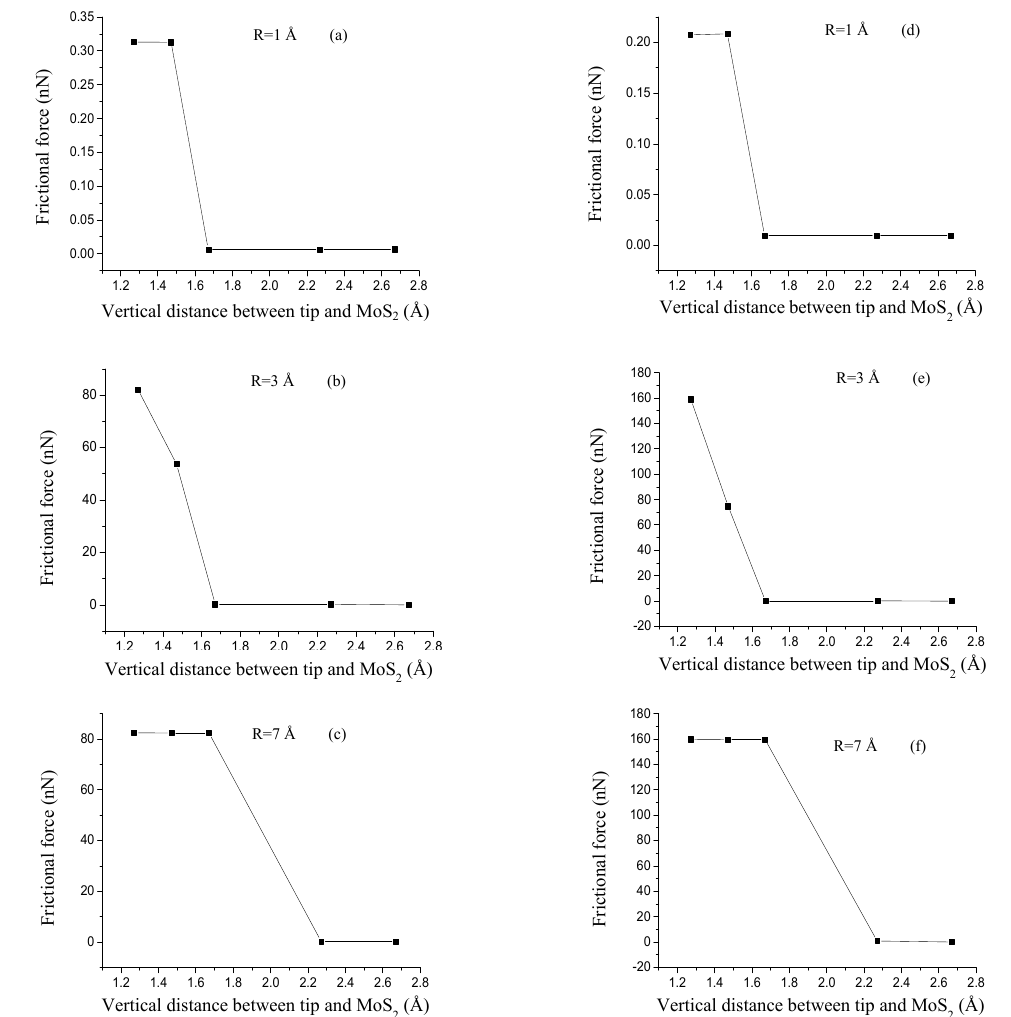
Figure 8. Variations in frictional forces for three different tips (radii of 1, 3, and 7 Å) sliding along the AC ( a – c ) and ZZ ( d – f ) orientation with five vertical distances between tips and MoS 2 , z = 1.27 Å, z = 1.47 Å, z = 1.67 Å, z = 2.27 Å, and z = 2.67 Å, respectively.